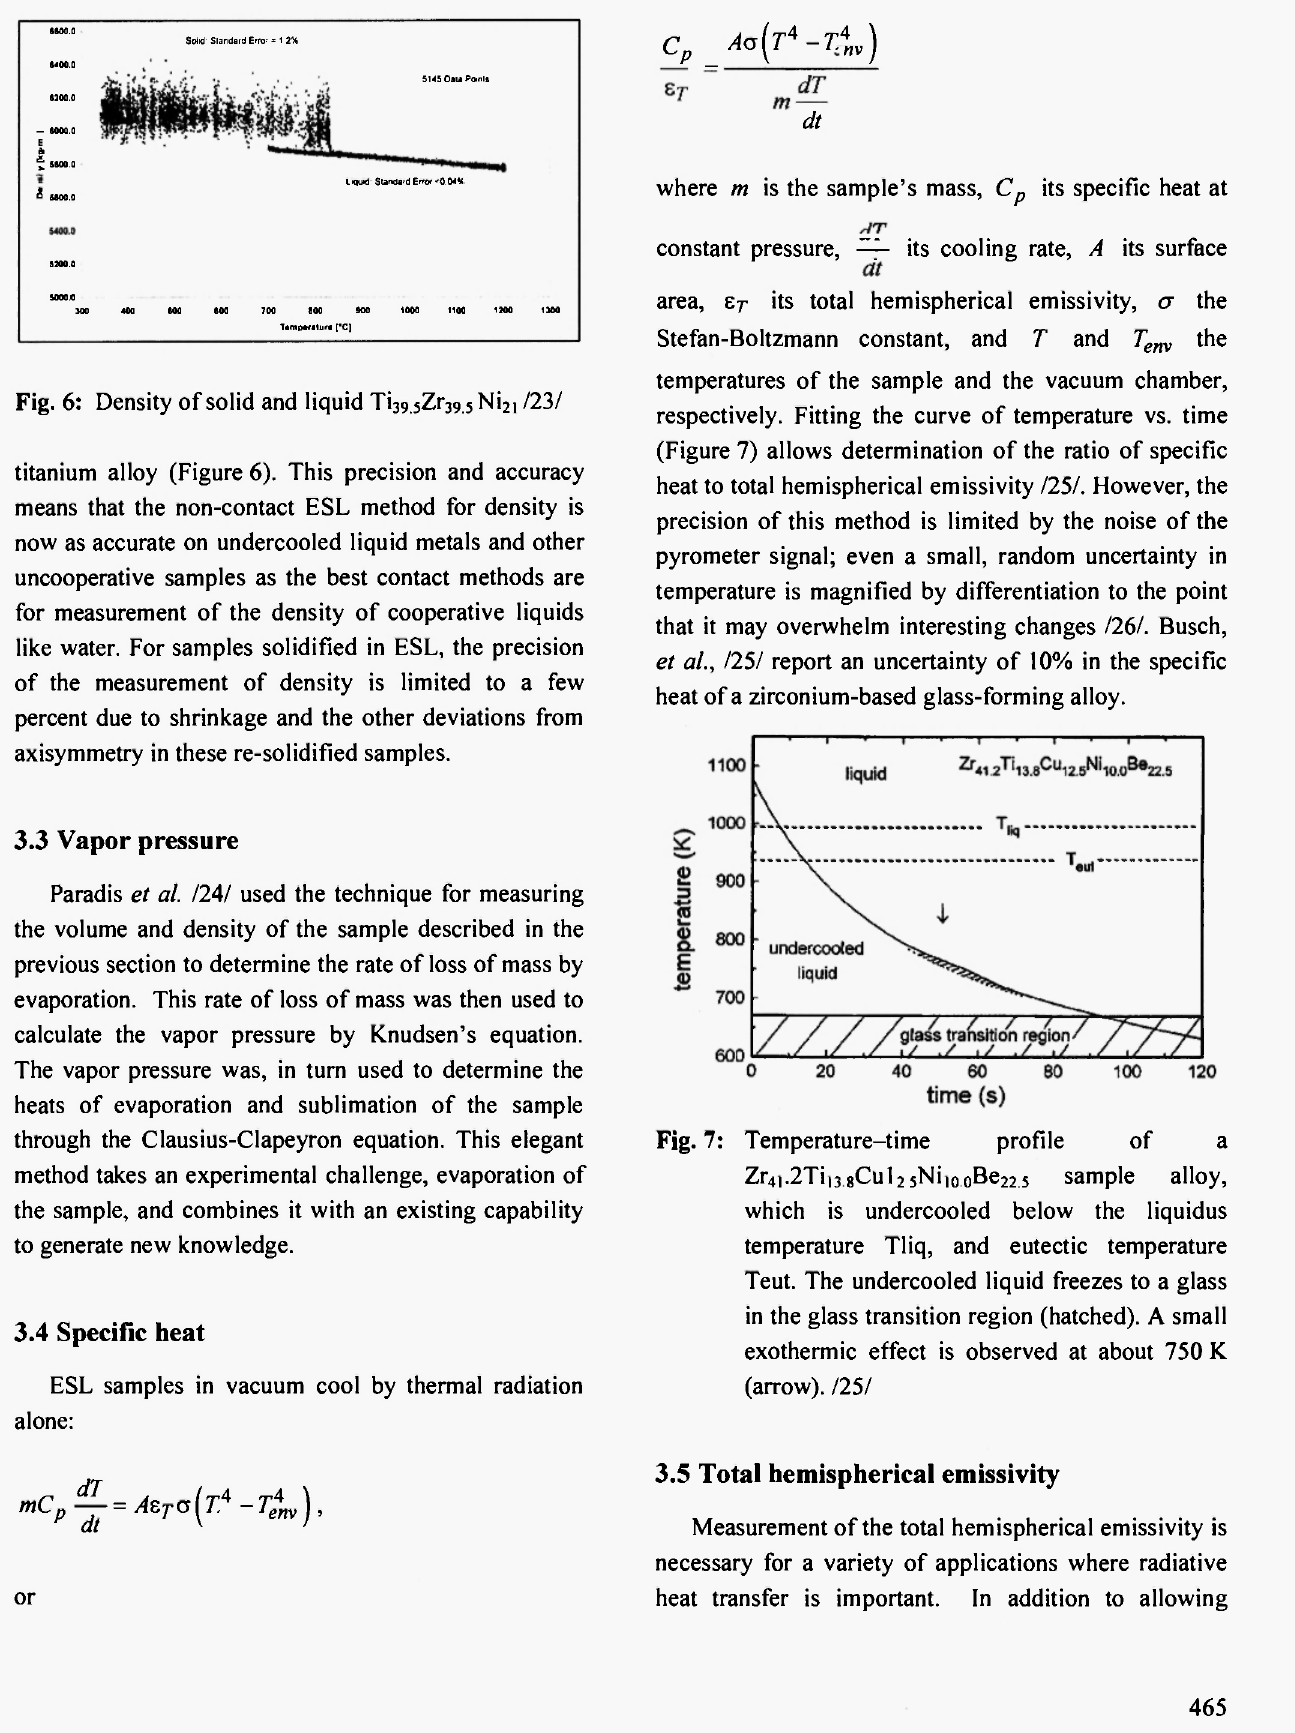
Fig. 6: Density of solid and liquid Ti 3 9 5Zr39 5 Ni2i 1221